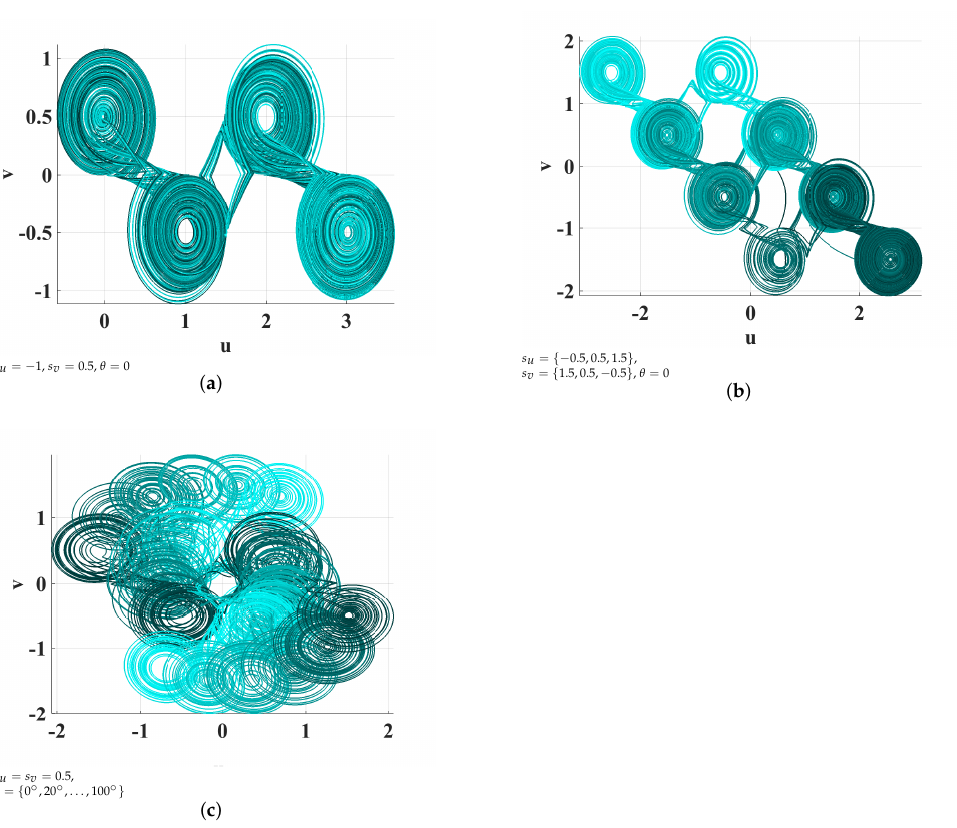
Figure 2. Two-dimensional ( a ) static translation, ( b ) dynamic translation, and ( c ) dynamic